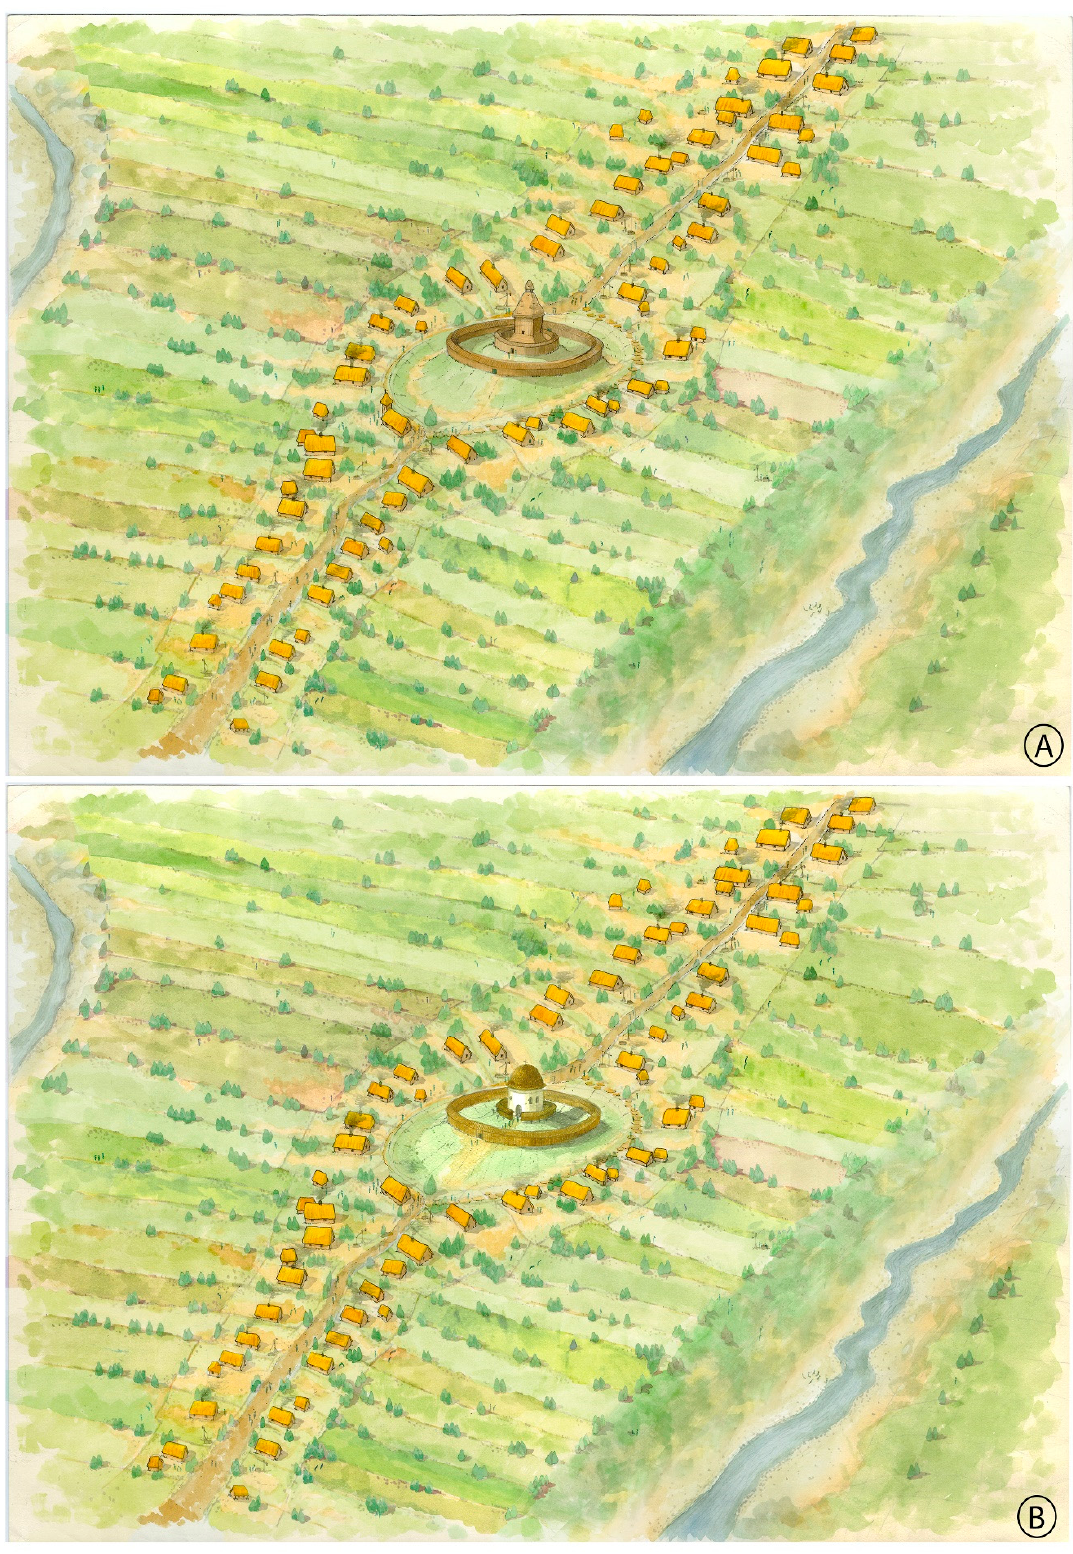
Figure 16. The hypothetical reconstruction of Machalaka medieval market-town based on all the information obtained from the results of this study. In the first scenario ( A ) the village has a tower in the middle, while in the second scenario ( B ) the fortifications enclose a circular church/chapel.